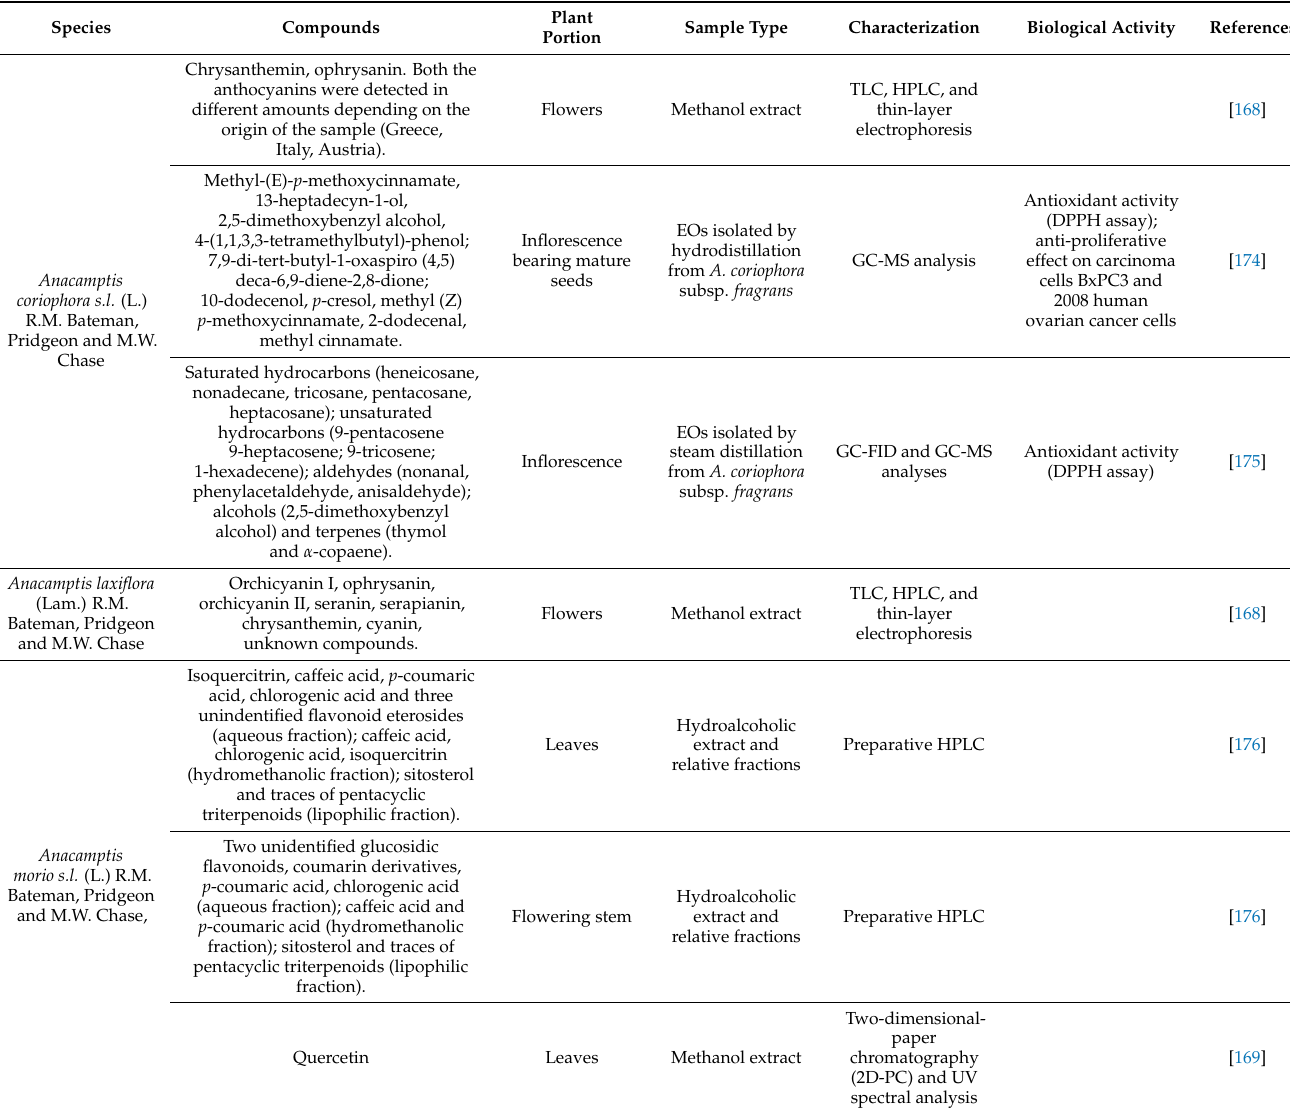
Table 2. Phytochemistry and evaluation of biological activities of European terrestrial